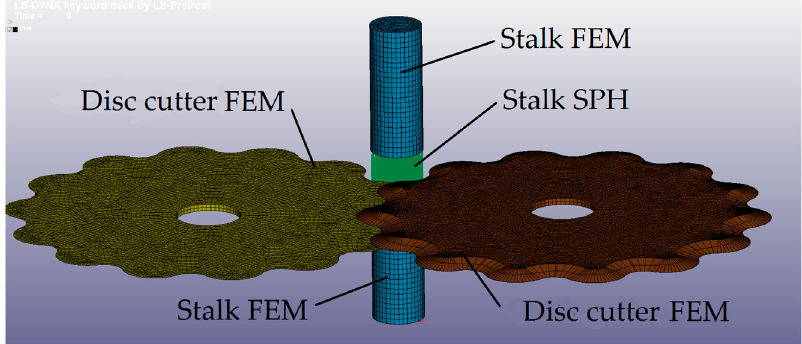
Figure 5. Simulation model using LS-DYNA software.